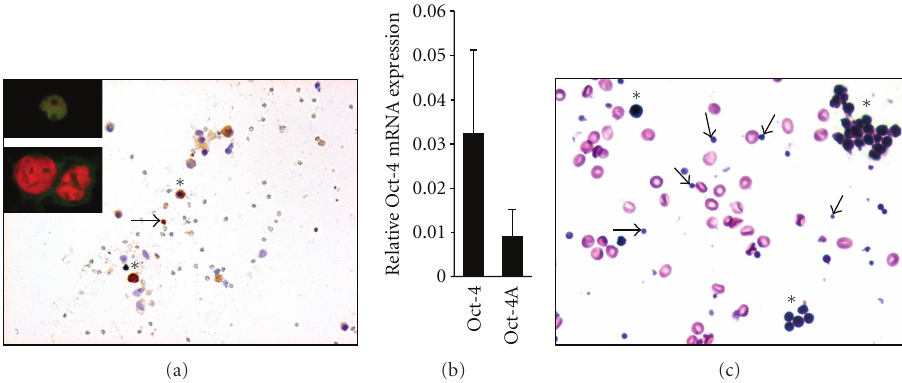
Figure 1: VSELs and OGSCs in adult mammalian ovary . (a) Immunolocalization of OCT-4, a stem cell marker on mouse ovarian cell smear using polyclonal antibody raised against C-terminal domain of OCT-4 (magnification 20x). Two distinct populations of stem cells were observed nuclear OCT-4 positive VSELs (arrow) and cytoplasmic OCT-4 positive OGSCs (asterisk). Inset is representative of the two stem cell populations by confocal microscopy using propidium iodide (PI) as a counterstain (magnification 63x with 5x optical zoom). VSEL has yellow stained nuclei as a result of co-localization of FITC labeled OCT-4 and PI whereas OGSC has distinct PI-stained red nuclei and cytoplasmic OCT-4. (b) Relative expression of Oct-4 and Oct-4A (transcript specific for pluripotent state) mRNA levels in normal mouse ovary by Q-PCR analysis. The levels of Oct-4A transcript in comparison to total Oct-4 were significantly lower suggesting that the VSELs positive for Oct-4A are less abundant compared to OGSCs. (c) H & E staining of human perimenopausal ovary surface epithelium smear showing the presence of RBCs, very small VSELs (arrow), and slightly bigger OGSCs (asterisk; present either as isolated cells or as clusters termed “germ cell nests” in developing ovary) (magnification 40x). Note the high nucleo-cytoplasmic ratio in stem cells with intense nuclear Hematoxylin